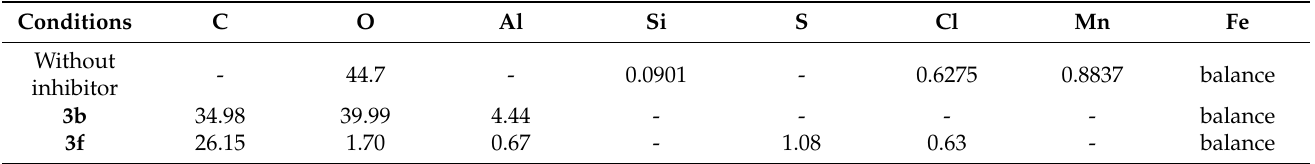
Table 4. Chemical analysis of plates observed under the microscope for the API 5L X70 steel at different conditions.